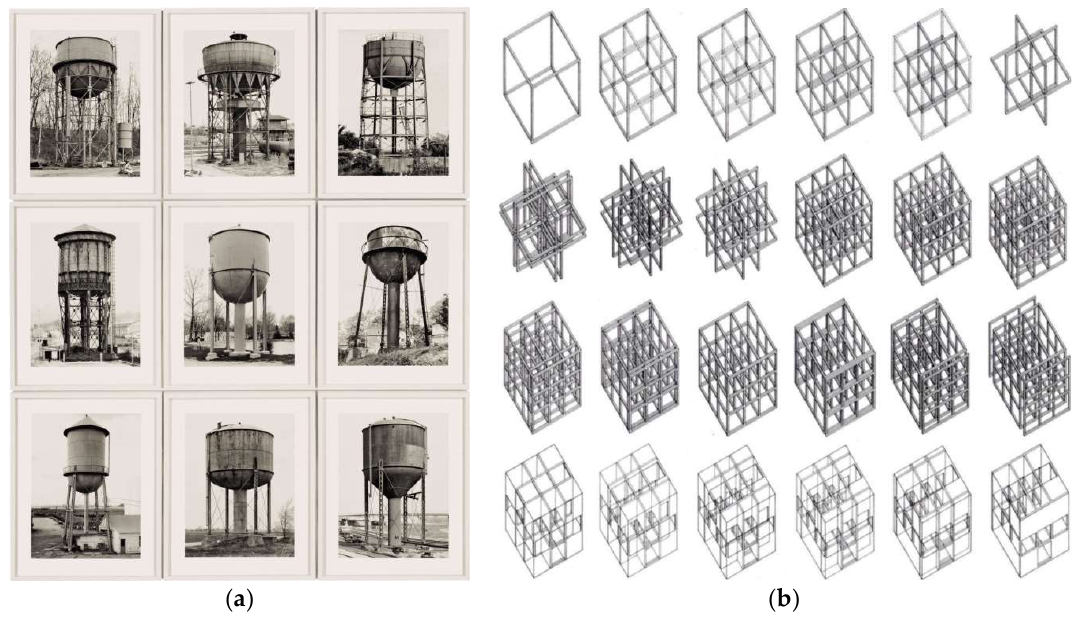
Figure 6. ( a ) Becher, B.; Becher, H. Typologien industrieller Bauten , 2003; ( b ) Peter Eisenman’s